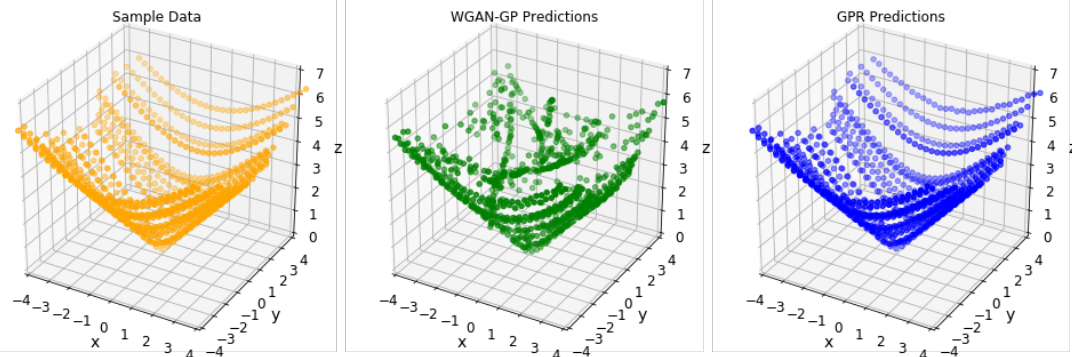
Figure 10. 2D distance function. The test data is shown on the left, sampled points from the WGAN are shown in the middle and sampled points from the GPR posterior are shown on the right.